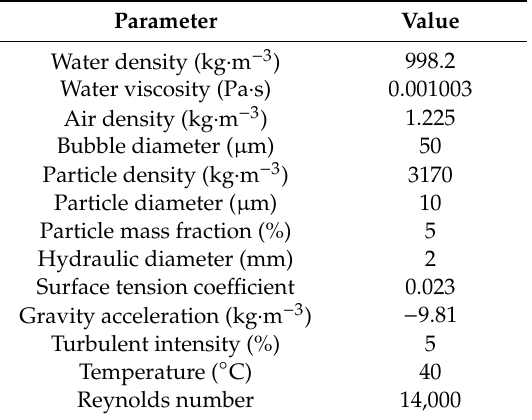
Table 5. Physical parameters for numerical